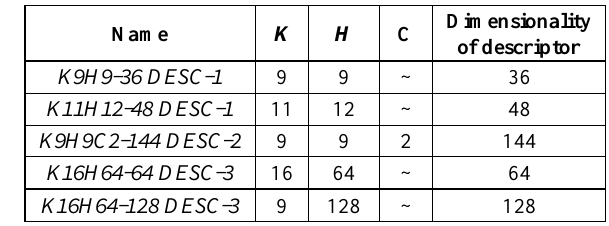
Table 3. Different configurations for DESC-1 , DESC-2 and DESC-3